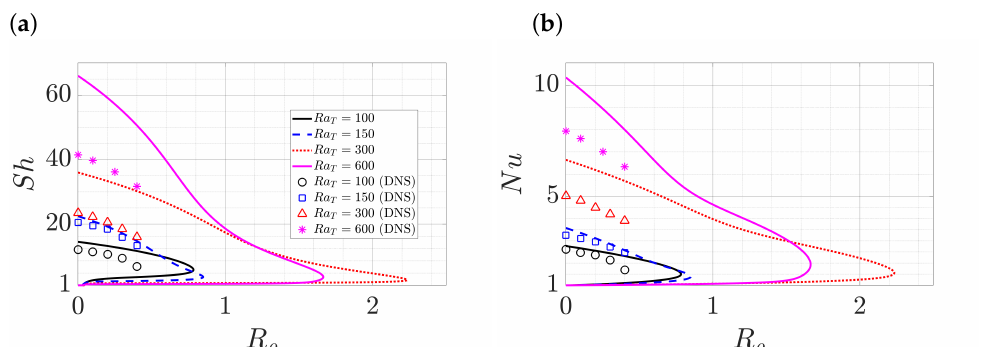
Figure 13. ( a ) Sh and ( b ) Nu , both as a function of R ρ from the single-mode equations (lines) at Le = 20, k y = 0 and Ra T = 100, 150, 300 and 600 with wavenumbers k x = n π / L x ,NBC = π , 2 π , 2 π , 4 π , respectively, compared with the corresponding DNS results (markers) (Figure 5 in